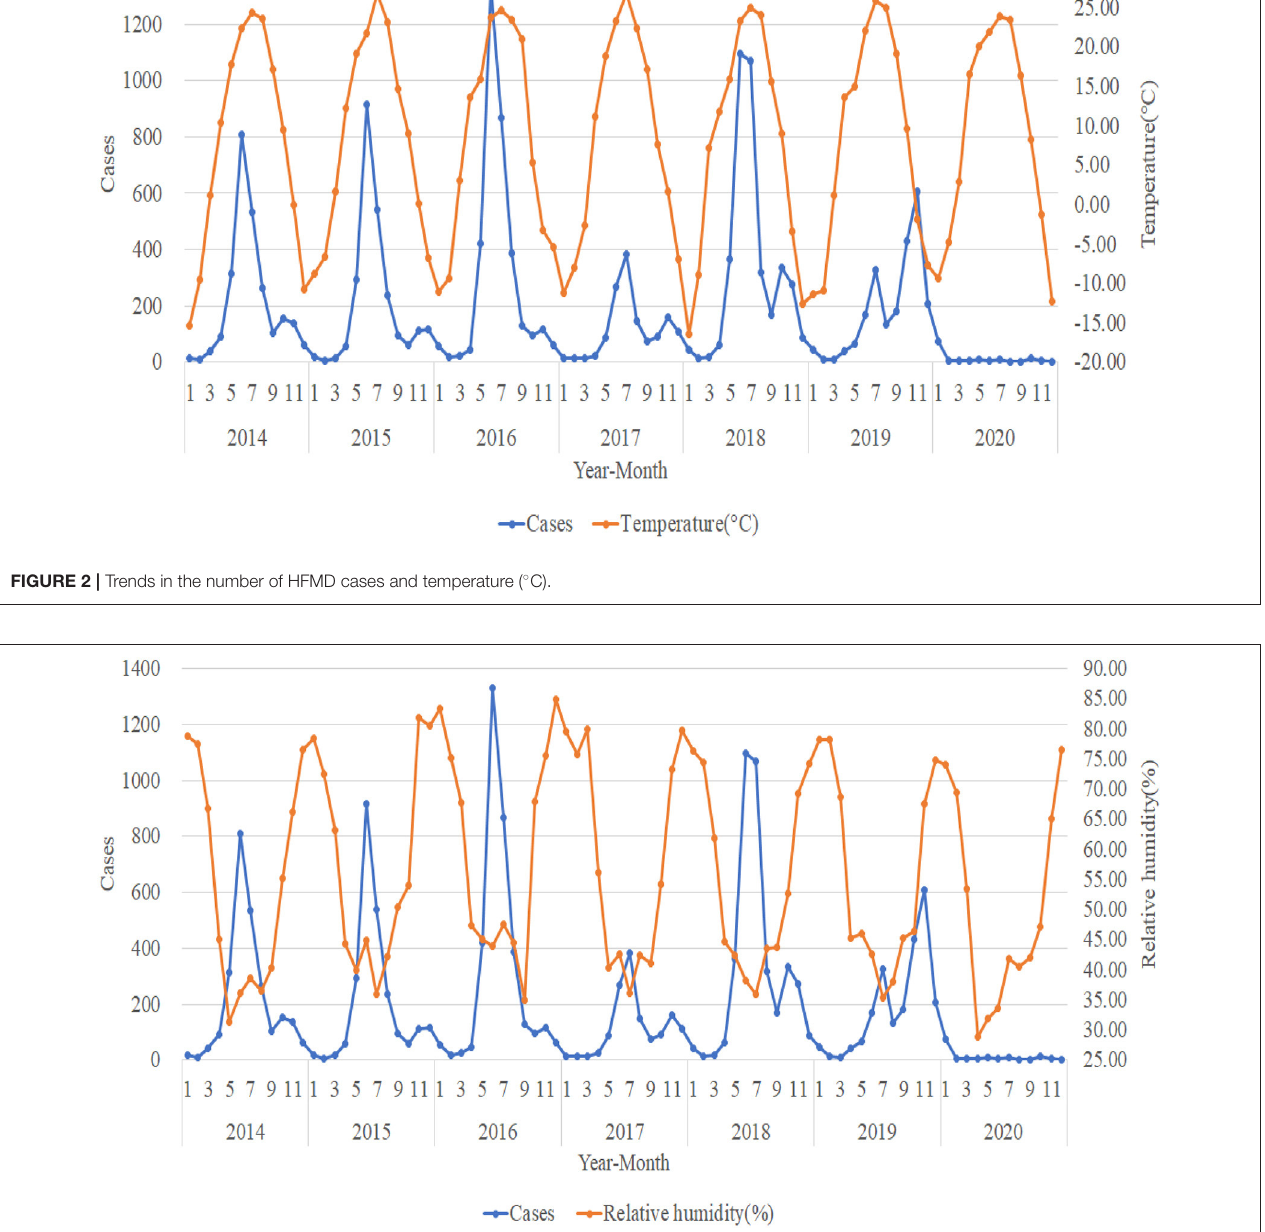
grows. The trend of relative humidity (%) is the opposite to the trend of the number of HFMD cases. When relative humidity (%) is low, the number of HFMD cases is higher, and accordingly, when relative humidity (%) is high, the number of HFMD cases is